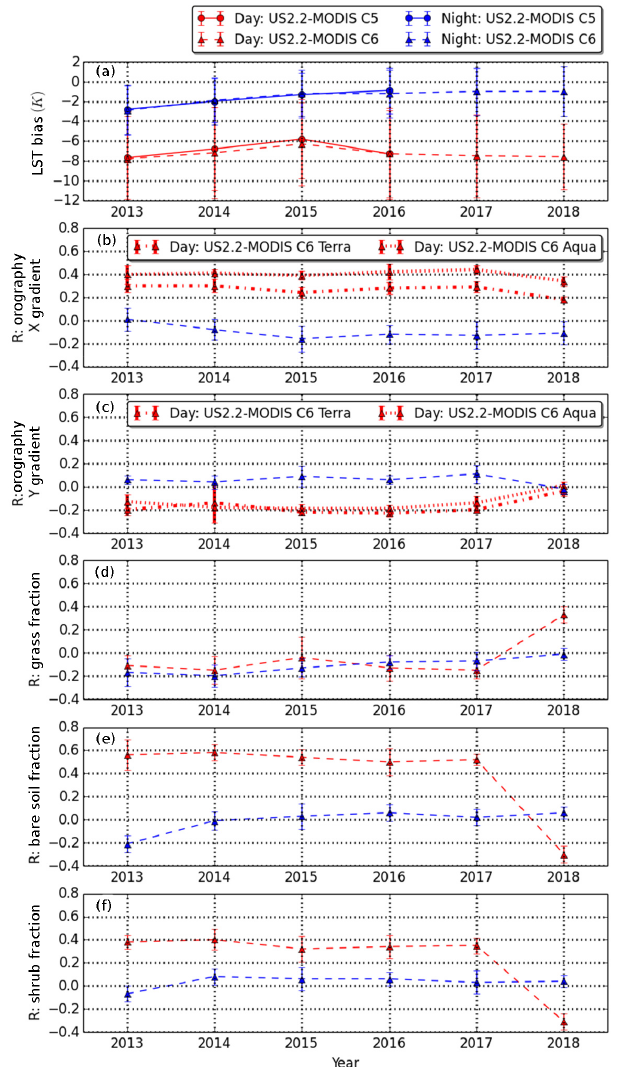
Figure 6. (a) US2.2 daytime (red) and night-time (blue) LST bi- ases determined from MODIS Collection 5 (solid) and Collection 6 (dashed) overpasses (the average of Terra and Aqua retrievals) ac- quired during the May 2013–2018 period. The coefficient of corre- lation ( R ) for daytime and night-time during the May 2013–2018 period between the surface temperature bias and (b) the US2.2 x component of the orographic slope, (c) the US2.2 y component of the orographic slope, (d) the grass fractional cover, (e) the bare soil fractional cover, and (f) the shrub fractional cover for the US2.2